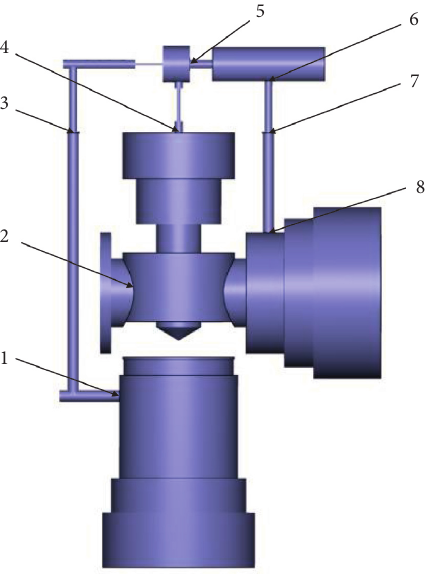
Figure 5: Interactive surfaces in relief valve